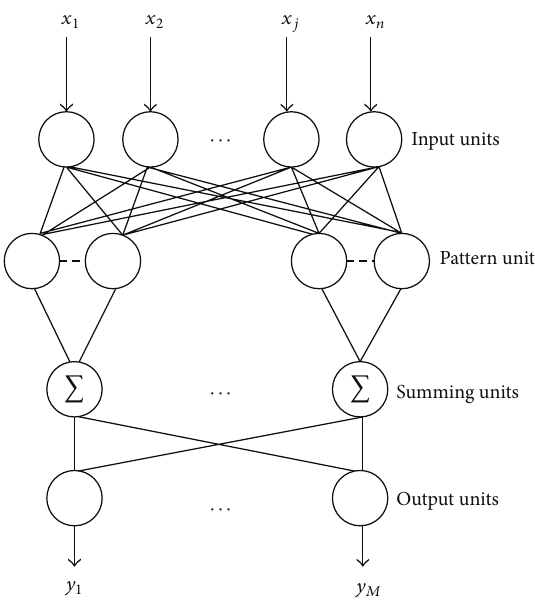
Figure 1: The topological structure of